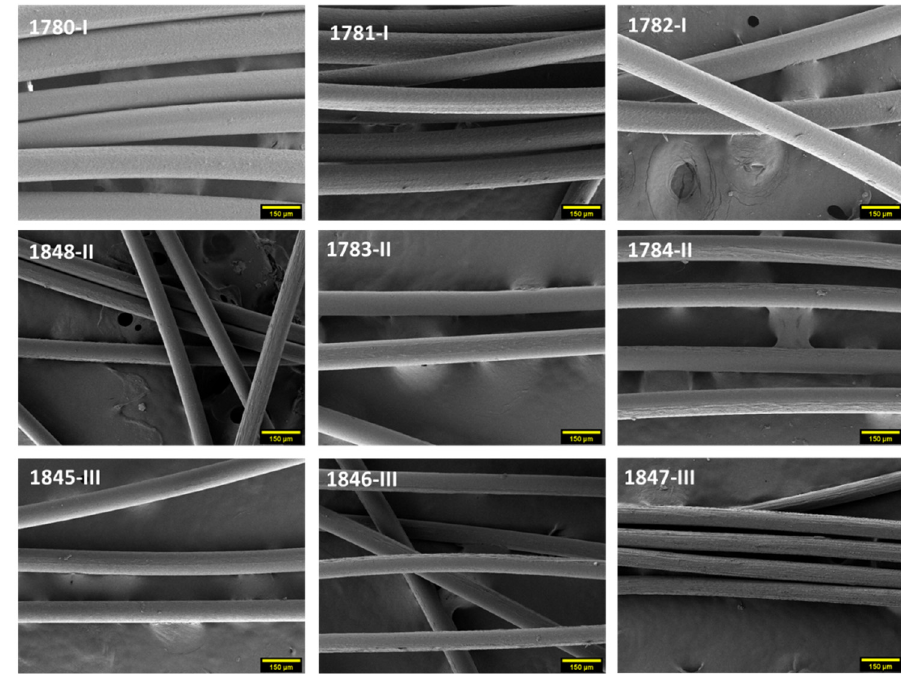
Figure 6. SEM images of PHBH monofilaments (magnification 250X, scale bar 150 µm).